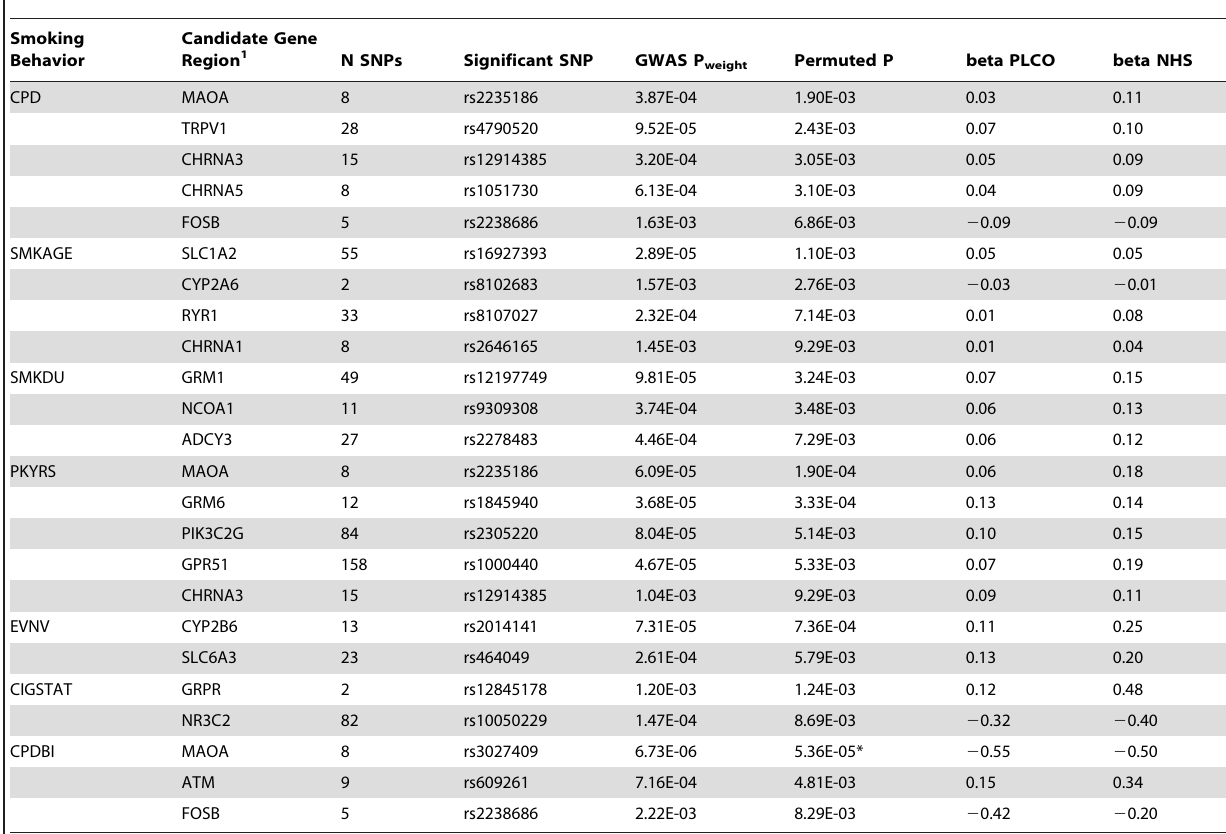
Table 3. Candidate gene results with gene-level P , 0.01 for seven smoking behaviors.